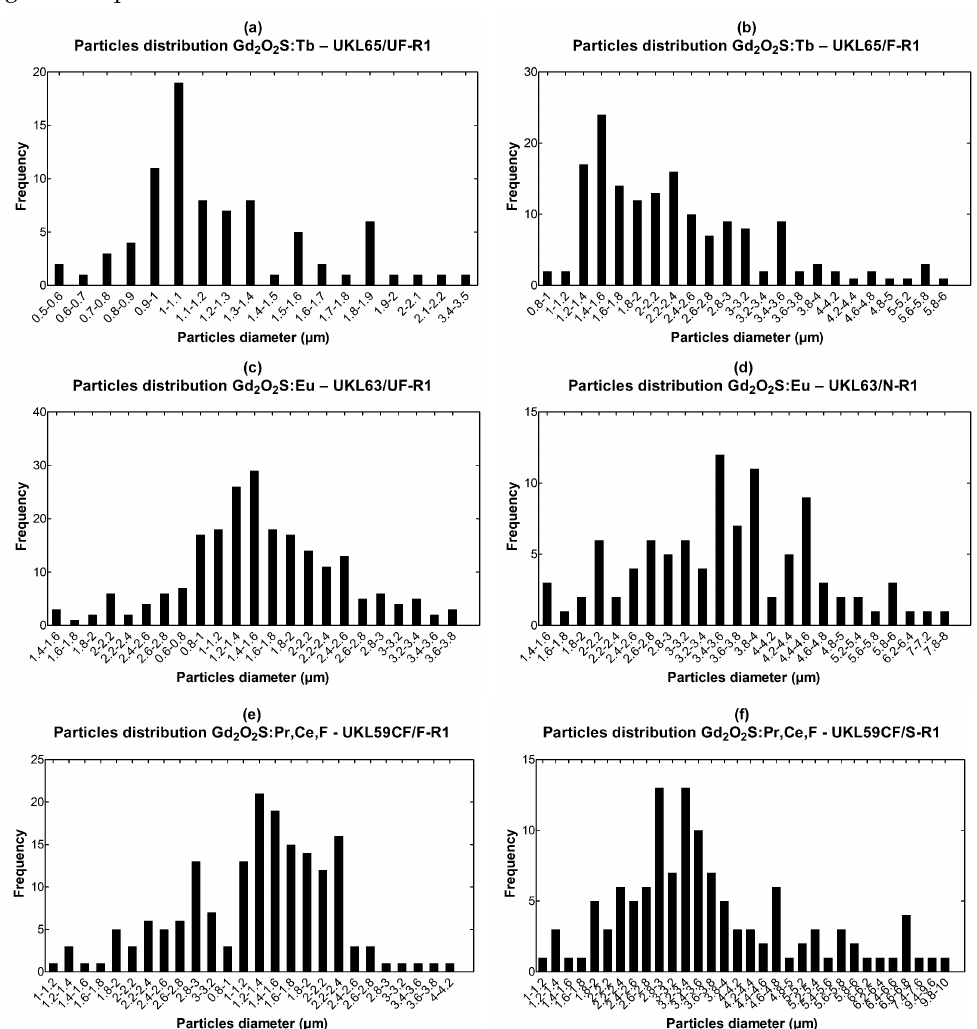
Figure 5. Grain size distributions of the: ( a ) Gd 2 O 2 S:Tb UKL65/UF-R1, ( b ) Gd 2 O 2 S:Tb UKL65/F-R1 ( c ) Gd 2 O 2 S:Eu UKL63/UF-R1, ( d ) Gd 2 O 2 S:Eu UKL63/N-R1, ( e ) Gd 2 O 2 S:Pr,Ce,F UKL59CF/F-R1, and ( f ) Gd 2 O 2 S:Pr,Ce,F UKL59CF/S-R1 phosphor samples.